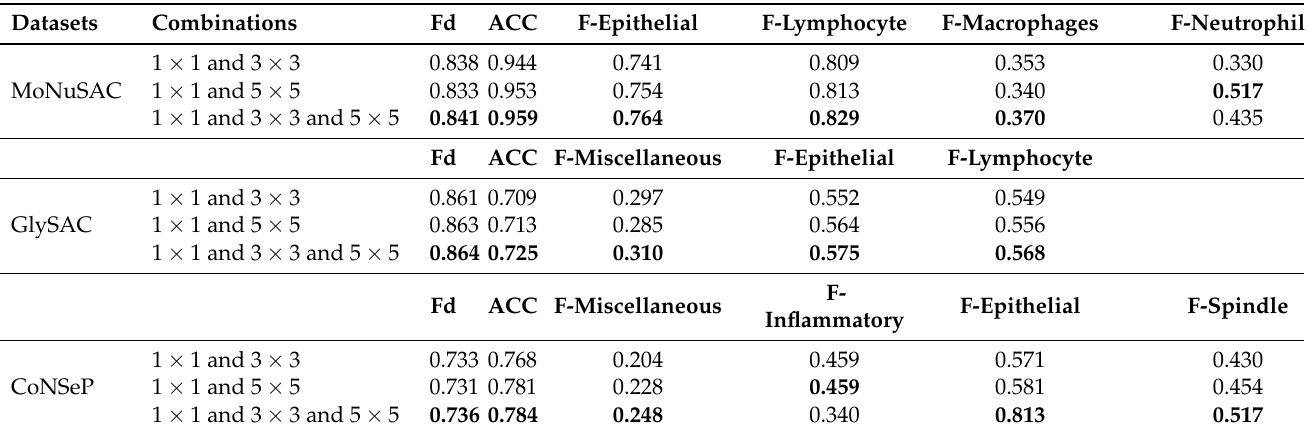
Table 3. Results of ablation experiments on cell classification.